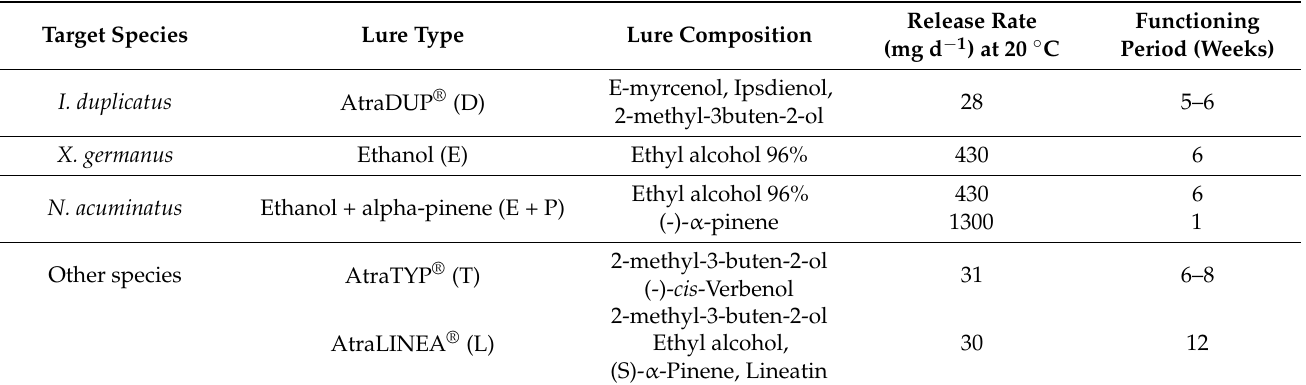
Table 1. The lure types used in the study and their characteristics.